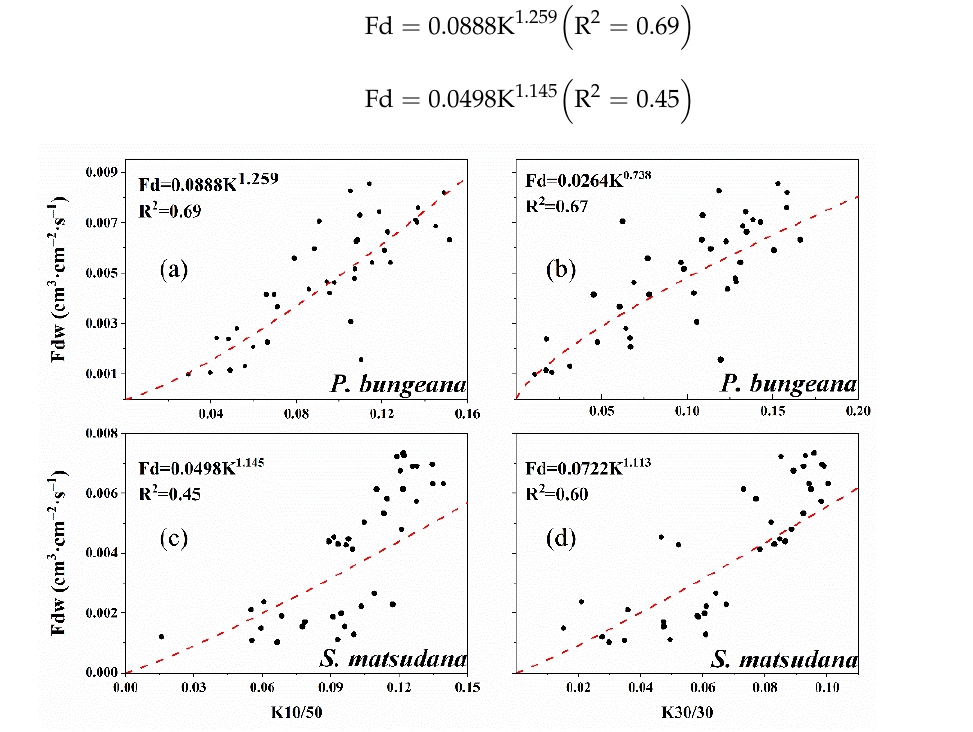
Figure 4. Relationship between K10/50(K for 10 min heating and 50 min cooling mode, (a) and (c)) and K30/30(K for 30 min heating and 30 min cooling mode, (b) and (d)) with reference sap flow density (Fd w , measured by tree weighing).